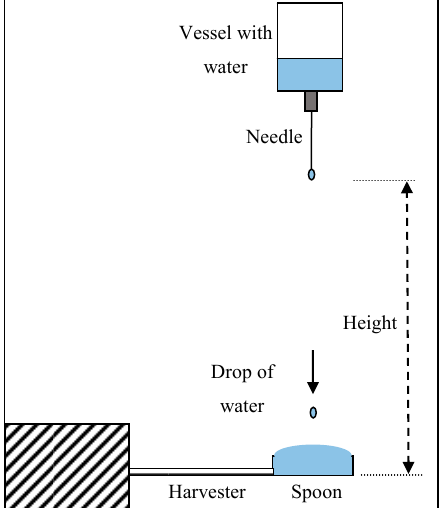
Figure 10. Experimental